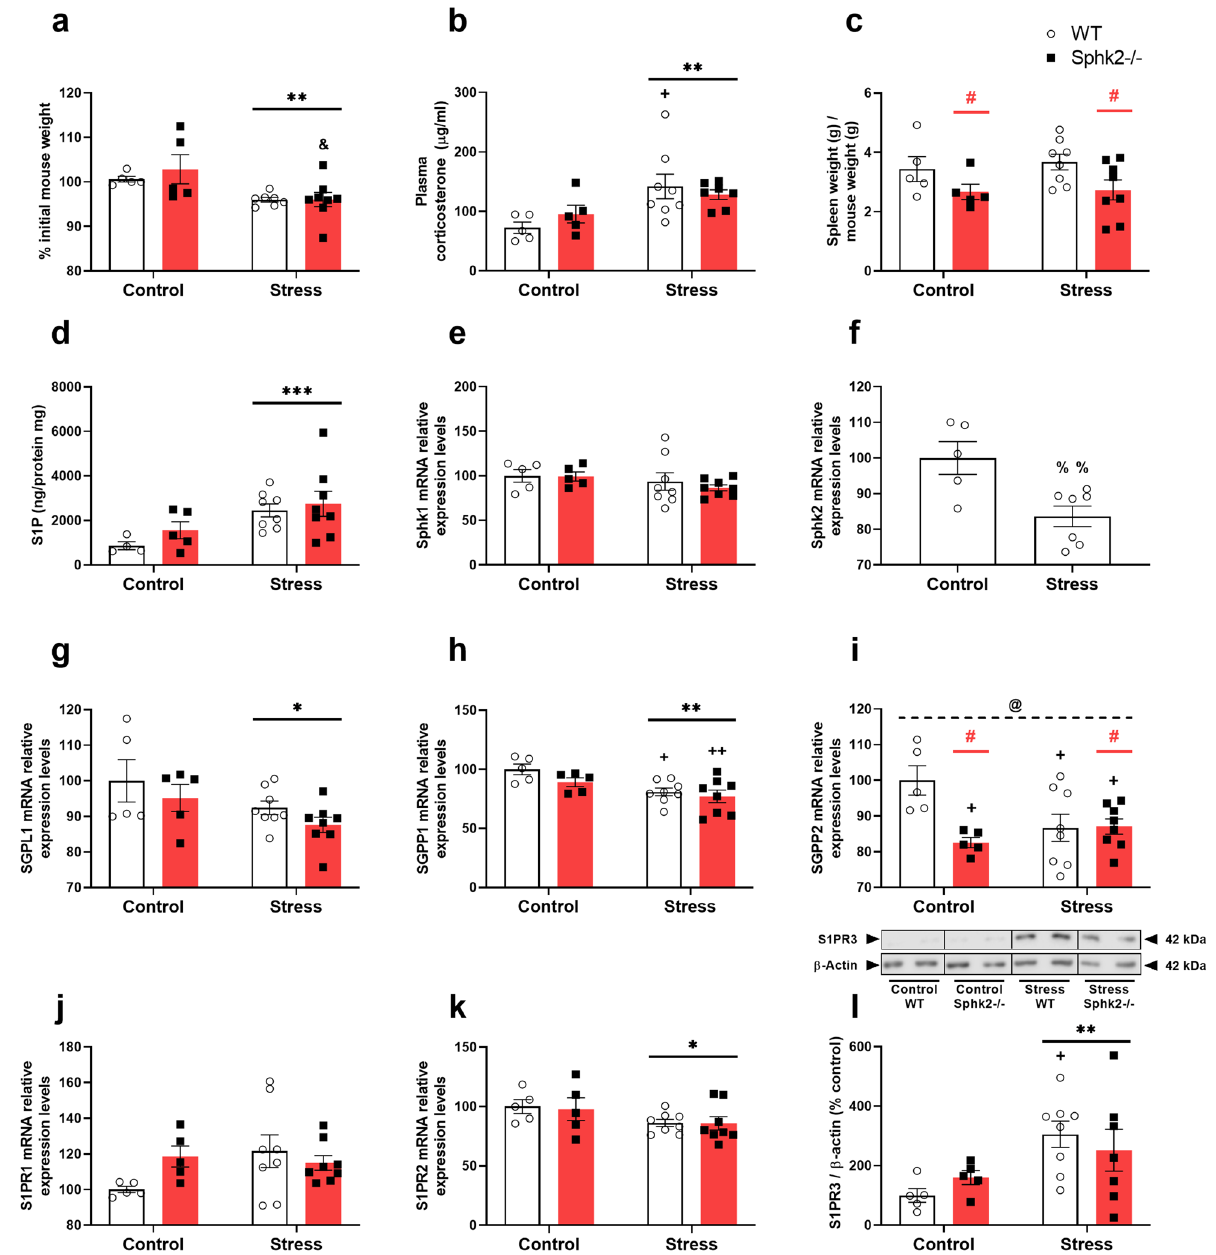
Figure 1. General stress effects and S1P pathways analyses in the colon of WT and Sphk2 mice after sub- chronic stress exposure. Percentage of weight gain after the stress protocol ( a ), plasma corticosterone levels ( b ), relative spleen weight ( c ), colon S1P levels ( d ), Sphk1 mRNA levels ( e ), Sphk2 mRNA levels ( f ), SGPL1 mRNA levels ( g ), SGPP1 mRNA levels ( h ), SGPP2 mRNA levels ( i ), S1PR1 mRNA levels ( j ), S1PR2 mRNA levels ( k ), S1PR3 protein expression ( l ). Data are means ± SEM of 5–8 mice per group. The densitometric data of the respective bands of interest are normalized by β-actin (lower band). Blots were cropped (black lines) to improve the clarity and conciseness of the presentation. Two-way ANOVA considering stress (S) and Sphk2−/− as independent variables followed by Tukey’s post hoc for ( a – l ); *S p < 0.05, **S p < 0.01, ***S p < 0.001; #Sphk2−/− p < 0.05; @ (interaction) p < 0.05; + p < 0.05, ++ p < 0.01 vs Control WT; & p < 0.05 vs Control Sphk2−/−. Two-tailed Student t-test for f; %% p < 0.01. Sphk2: sphingosine kinase 2; WT: wild-type; Sphk2−/−: Sphk2 knockout; S1P: sphingosine-1-phosphate; Sphk1: sphingosine kinase 1; SGPL1: sphingosine-1-phosphate lyase 1; SGPP1: sphingosine-1-phosphate phosphatase 1; SGPP2 sphingosine-1-phosphate phosphatase 2; S1PR1: sphingosine- 1-phosphate receptor 1; S1PR2: sphingosine-1-phosphate receptor 2; S1PR3: sphingosine-1-phosphate receptor